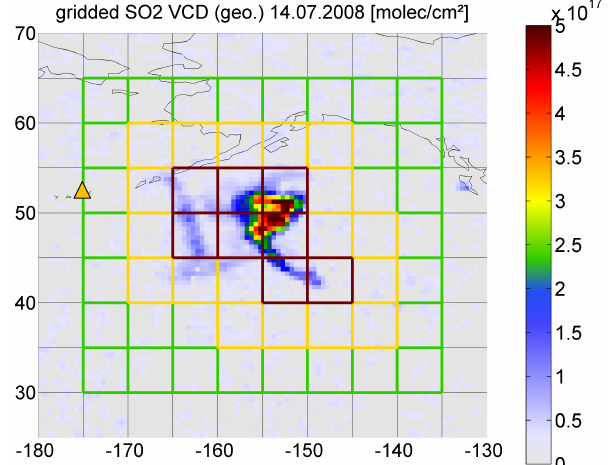
Fig. 3. Automatic detection of the volcanic SO 2 plume after the eruption of the Okmok volcano (orange triangle) on 14 July 2008. The red frames in the centre region highlight the detected SO 2 plume event boxes (PEBs) that were identified to contain parts of the volcanic plume. Neighbouring boxes are assigned to each specific PEB in order to capture also those parts of the volcanic plume where the VCDs were not sufficiently high to be identified as an individual PEB (yellow boxes). Finally, in order to get a reference area next to the captured SO 2 plume events, all non-SO 2 PEBs within another surrounding box that exceeded from ± 5 ◦ from the max/min latitu- dinal/longitudinal grid pixel position of the SO 2 PEB cluster were registered (green